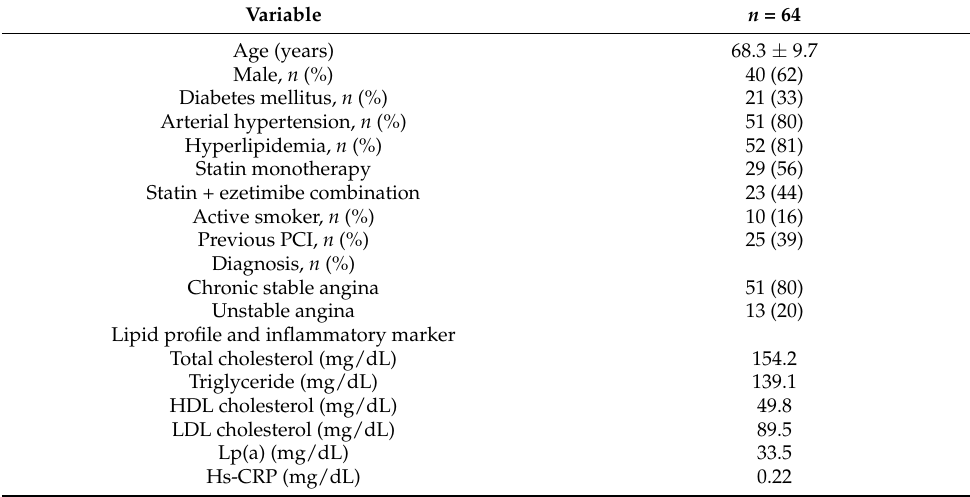
Abbreviations: PCI, percutaneous coronary